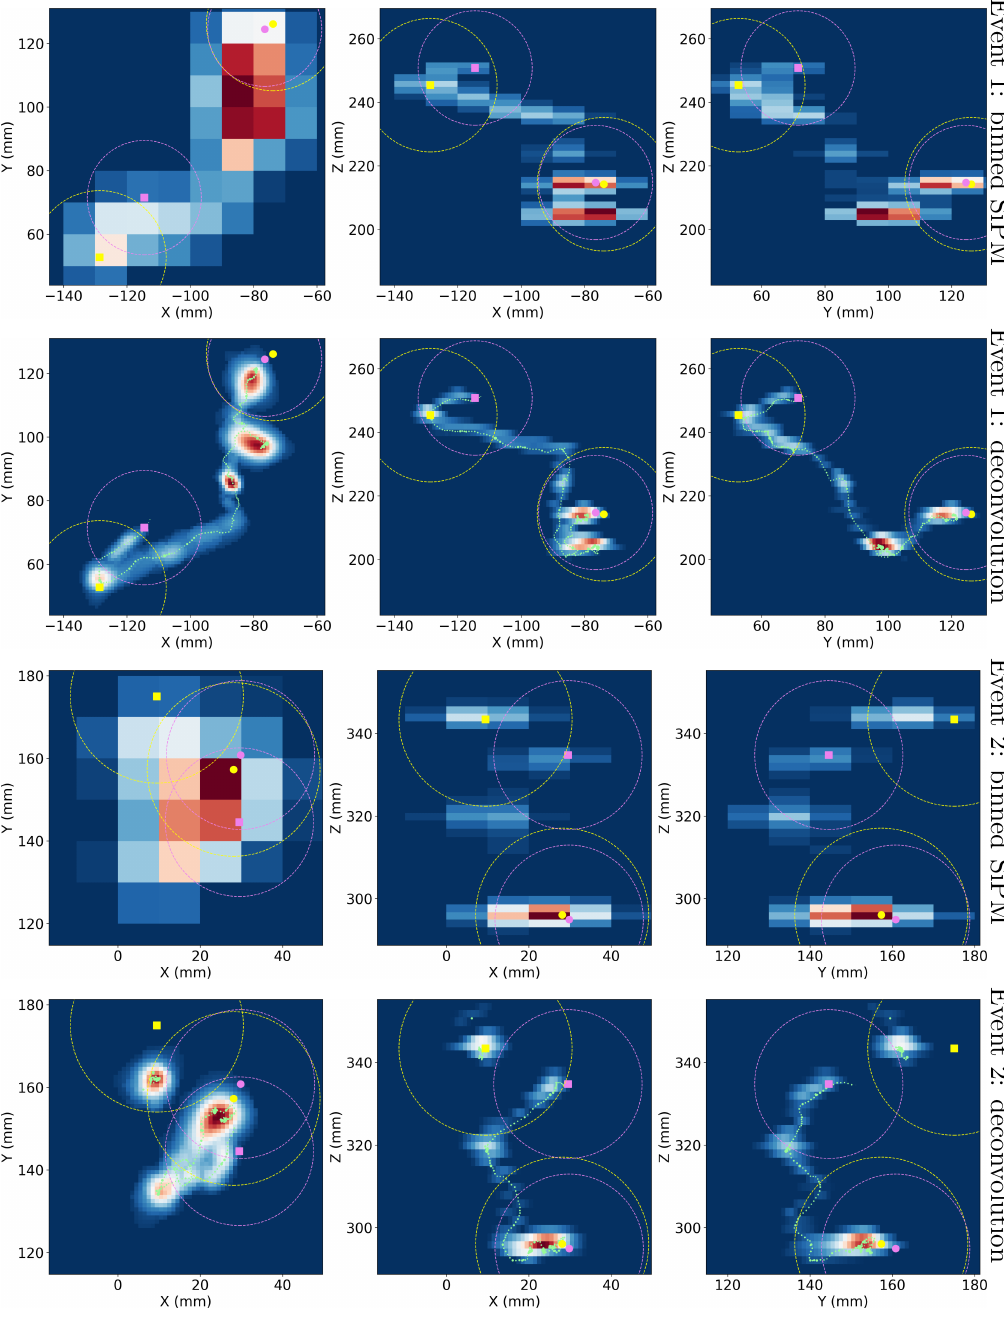
Figure 22 . Single electron events (background) in the pair production ROI misclassified by the classical analysis as signal and correctly identified as background by the RL process. For each event the top row is the binned SiPM response, and the bottom row — the deconvolved projections. Yellow symbols mark the track ends found by the classical analysis, purple — by the RL process. Squares are blob2 centers, circles — those of blob1. The true track is overlaid on the deconvolved images. Misclassification of Event 1 results from a merger between the start point of the track and its main part. Event 2 (double Compton scatter) is misidentified as a single track because of the limited resolving power of the classical